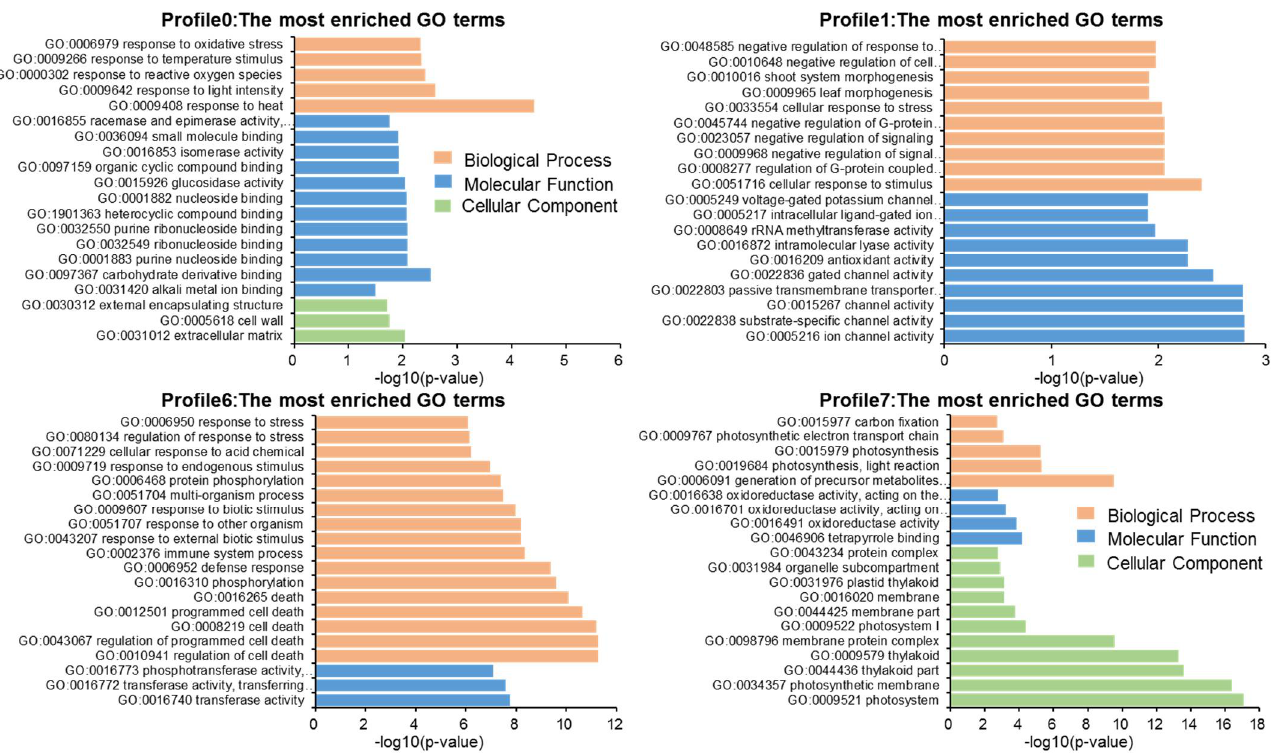
Figure 4. The most enriched GO terms of 4 clusters which were significantly different.